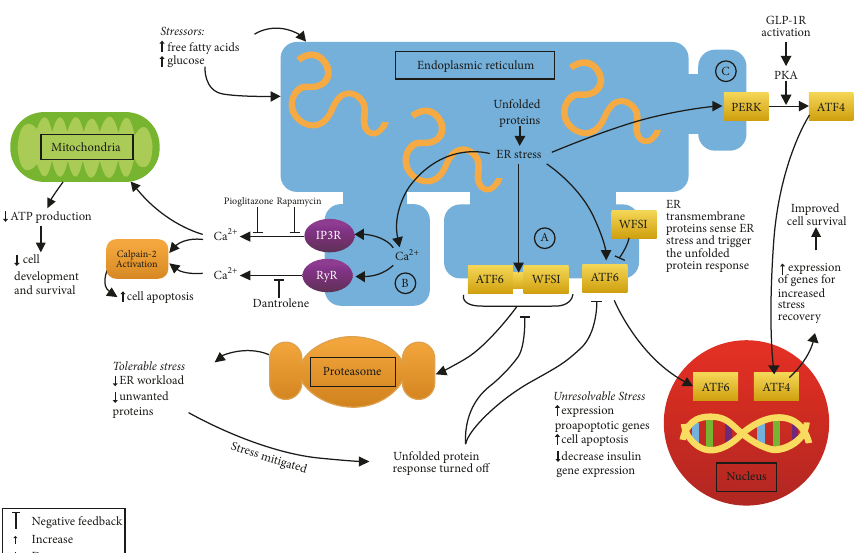
Figure 1: Hypothesized molecular pathophysiology of WS. Under situations of stress, such as hyperglycaemia and elevated free fatty acids levels, unfolded and misfolded proteins accumulate [31]. Endoplasmic reticulum (ER) transmembrane proteins sense the stress and activate the unfolded protein response (UPR) [31]. The UPR may culminate in either an adaptive response which decreases the workload on the ER or a maladaptive response (as occurs in chronic hyperglycaemia or WS) which culminates in cellular apoptosis [31]. (cid:2) In healthy cells, the transmembrane protein (WFS1) complexes with activating transcription factor-6 (ATF-6) and directs ATF-6 to ubiquitin-mediated proteasome degradation [31]. This serves to negatively regulate the UPR [31]. In WFS1 deficient cells ATF-6 is no longer under negative inhibition and is permitted to constitutively activate genes that promote cellular apoptosis and decrease insulin gene expression [31]. (cid:3) ER calcium channels, such as the ryanodine receptor (RyR), but most importantly the inositol triphosphate receptor (IP3R), permit efflux of calcium from the ER to the cytosol [16, 28]. It is believed that increased cytoplasmic calcium levels activate the calcium-dependent protease, calpain-2, which promotes cellular apoptosis [16, 34]. Potential therapeutic targets include molecules which inhibit calcium efflux from the ER, such as dantrolene, via inhibition of the RyR [35], and rapamycin and pioglitazone, via inhibition of IP3R [34]. In neuronal WS models, cytosolic calcium appears to be increased under resting conditions and reduced under stimulated conditions [28]. This disruption in cytoplasmic calcium homeostasis also dysregulates mitochondrial dynamics which leads to lower ATP levels [28]. This is thought to hinder neuronal development and survival [28]. D Under periods of ER stress, pancreatic ER kinase (PERK), a transmembrane ER protein, becomes activated and through the action of protein kinase A (PKA) and cyclic-AMP (cAMP) results in the phosphorylation of translation initiation factor 2 𝛼 (eIF2 𝛼 ) (not shown) [36]. This in turn results in increased production of activating transcription factor 4 (ATF4) which increases the expression of genes for ER stress recovery [31, 36, 37]. Furthermore, phosphorylated eIF2 𝛼 leads to decreased overall protein synthesis and therefore to reduction in the ER protein load (not shown) [36]. Glucagon-like peptide-1 receptor (GLP-1R) activation, acting downstream of PERK, decreases the phosphorylation of eIF2 𝛼 via the PKA/cAMP pathway, in order to ameliorate the decrease in protein synthesis that would otherwise occur (not shown) [36, 37]. This mechanism of action of GLP-1R activity facilitates a faster resumption of protein synthesis following ER stress (not shown) [36,